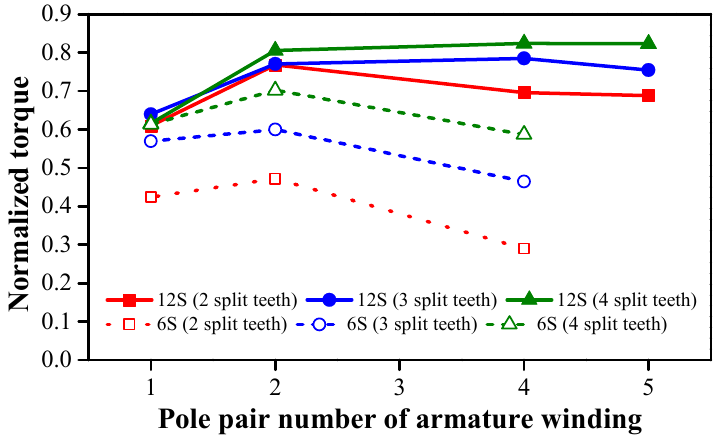
Figure 14. Torques versus stator slot number, armature pole pair number, and split-tooth number when rotor slot number is selected as nN s − P a .